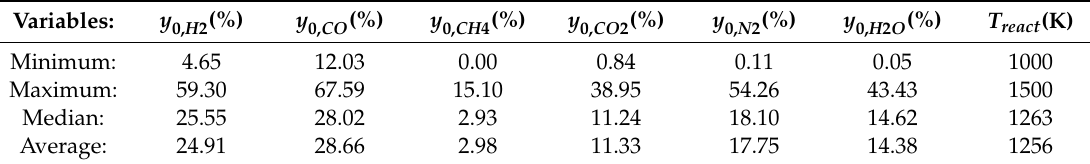
Table 2. Variables sampling bounds (minimum and maximum), median, and average values through the Morris sampling technique.